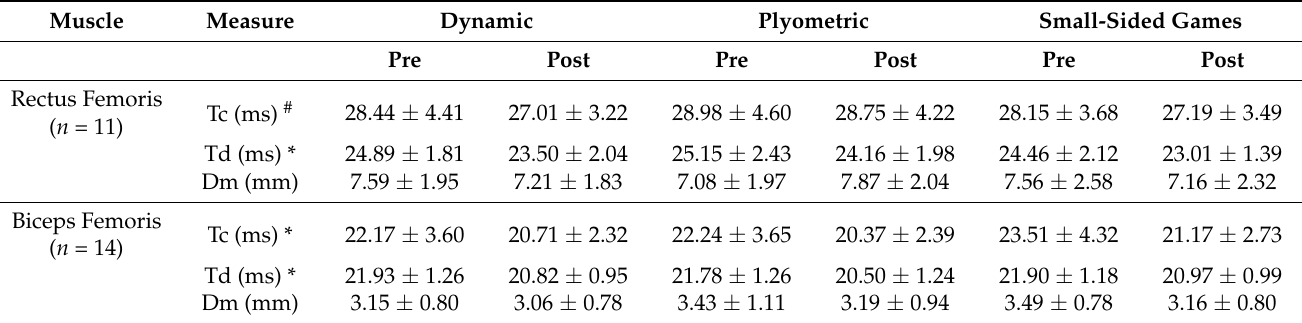
Table 2. Pre- and post-warm-up tensiomyography measurements (collapsed across right and left legs).